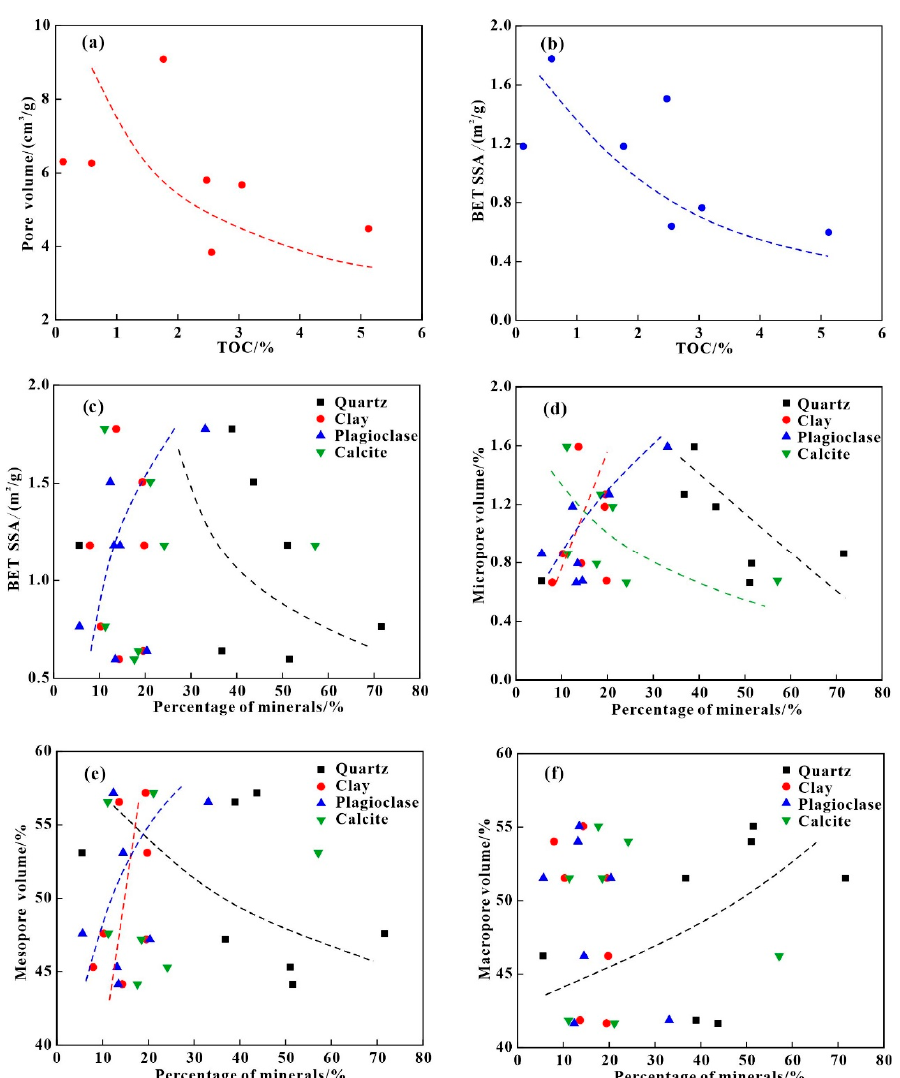
Figure 9. Influencing factors of shale pore structures from Fengcheng Formation: ( a ) Relationship between PV and TOC. ( b ) Relationship between SSA and TOC. ( c ) Relationship between SSA and percentage of minerals. ( d ) Relationship between micropore volume and percentage of minerals. ( e ) Relationship between mesopore volume and percentage of minerals. ( f ) Relationship between macropore volume and percentage of minerals.